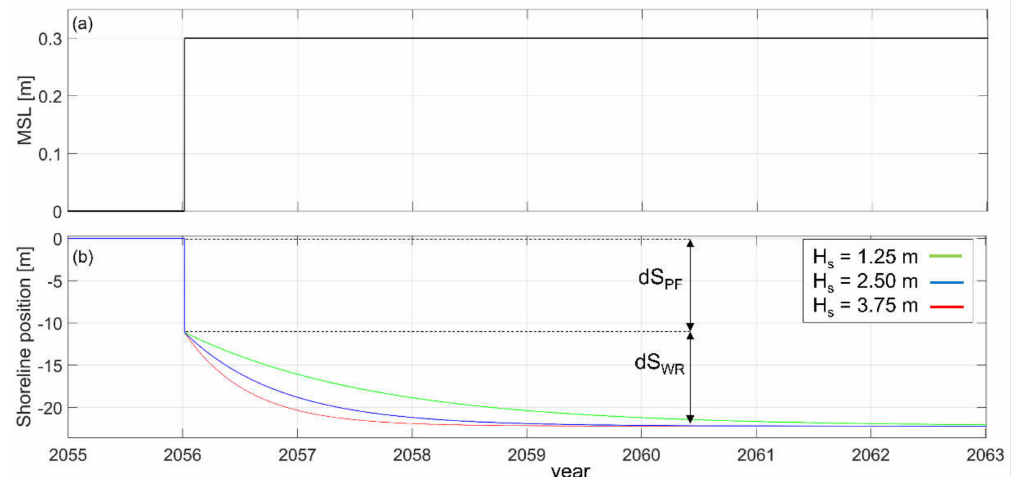
Figure 4. Application of the approach proposed in Equation (15), using constant wave energy and a 30 cm instantaneous sea-level rise. ( a ) Mean sea-level time series used in the application; ( b ) shoreline response showing the instantaneous passive flooding and the progressive effect of wave reshaping for a constant mean incident wave height of 1.25 m (green line), 2.50 m (blue line) and 3.75 m (red line). Table 1. Simulation setup information including the governing equation, disequilibrium approach, SLR approach and calibrated model free parameters. The (*) symbol indicates that the feedback between the models is enabled.